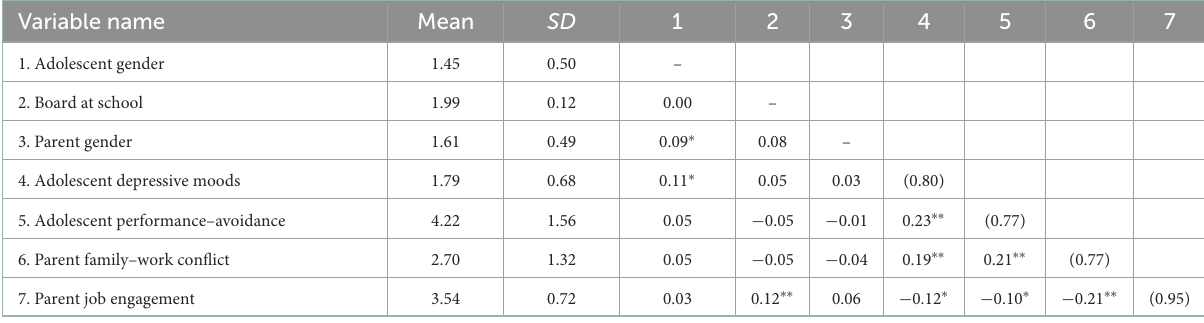
TABLE 1 Descriptive statistics and correlations among study variables.